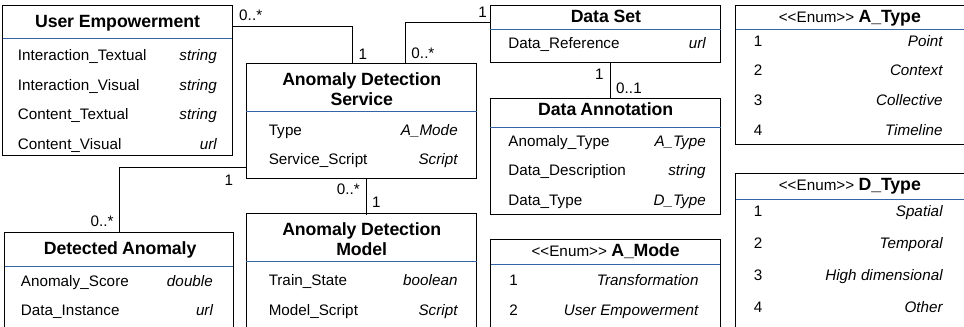
Figure 9. Information model for the conceptualized